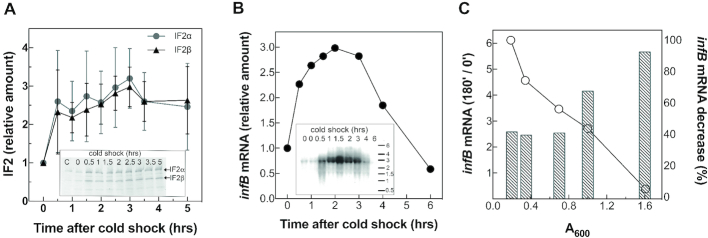
Variation of the cellular levels of IF2 and infB mRNA as a function of cell density and following cold stress. (A) Relative increase of IF2α (•) and IF2β (▴) levels at the indicated times after a cold stress induced by shifting from 37 to 10°C a cell culture that had attained A600 = 0.5 with respect to the pre-shock level (time 0) taken as = 1.The amount of IF2 was estimated semi-quantitatively by subjecting western blots developed using a rabbit polyclonal anti-IF2 serum as described (6) to densitometry using a BioRad imaging densitometer GS-670. The error bars refer to the standard deviation calculated on the relative increase of the IF2 level from results obtained in three separate experiments carried out in duplicate. The inset shows a typical western blot of purified IF2α and IF2β (lane C) and of the factor present in extracts of cells at the onset of cold stress (time 0) and at the times of cold stress indicated above each lane. (B) Relative increase of the infB mRNA level at the times after the cold shock indicated in the abscissa with respect to the pre-shock (time 0) level taken as = 1. The amount of the mRNA was quantified from the radioactivity of the northern blot bands as detected by a BioRad FX molecular imager. A typical northern blot is presented in the inset; the numbers above the individual lanes indicate the time (hours) elapsed since the onset of the cold stress that is indicated as ‘0’. An RNA ladder (Thermo Scientific RoboRuler High Range RNA Ladder 200–6000 bases) is presented on the right side; (C) decreasing level of infB mRNA (○) as a function of the cell density (reported in the abscissa) of a culture growing in LB at 37°C. The decreasing infB mRNA level is expressed on the right side y-axis as %, taking as 100% the level detected at cell density A600 = 0.2. The histogram bars (left y-axis) indicate the ratios between the infB mRNA levels in cells cold-stressed for 180 min at the cell density indicated in the abscissa and the levels determined before cold-shock (time 0) induced at the corresponding cell density.